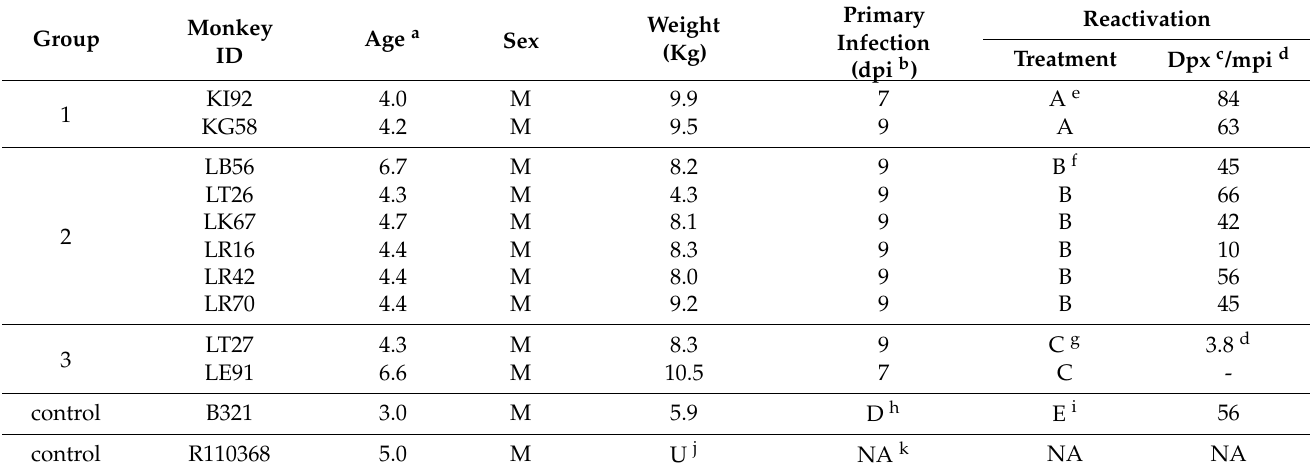
Table 1. List of monkeys used in this